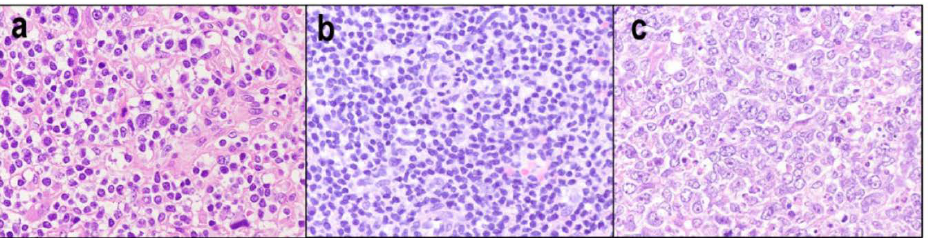
Figure 9. Cytological spectrum of peripheral T-cell lymphoma, NOS. ( a ) Pleomorphic medium- and large-sized type (HE 400). ( b ) Pleomorphic small cell type (HE × type (HE ×